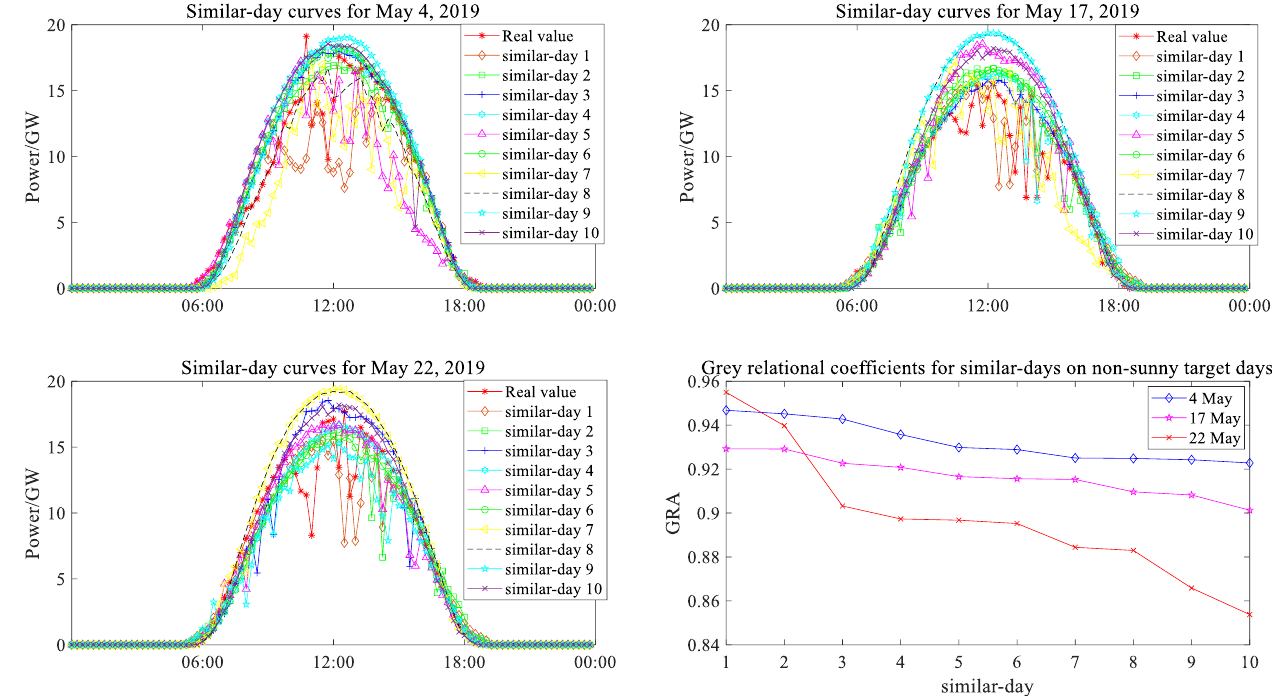
Figure 6. Similar-day curves for non-sunny target days and their grey relational coefficients.